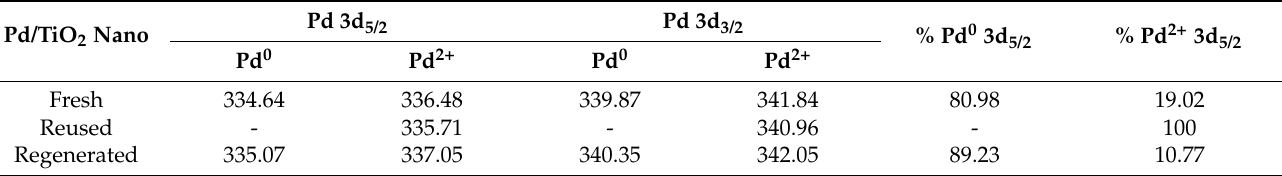
Figure 11. X-ray photoelectron spectroscopy (XPS) patterns of Pd 3d for ( a ) fresh, ( b ) after uses and ( c ) after regeneration (with H 2 ) of Pd/TiO 2 nano catalyst. Table 5. X-ray photoelectron spectroscopy (XPS) values of binding energies for the fresh, reused and regenerated (with H 2 ) Pd/TiO 2 nano catalyst.